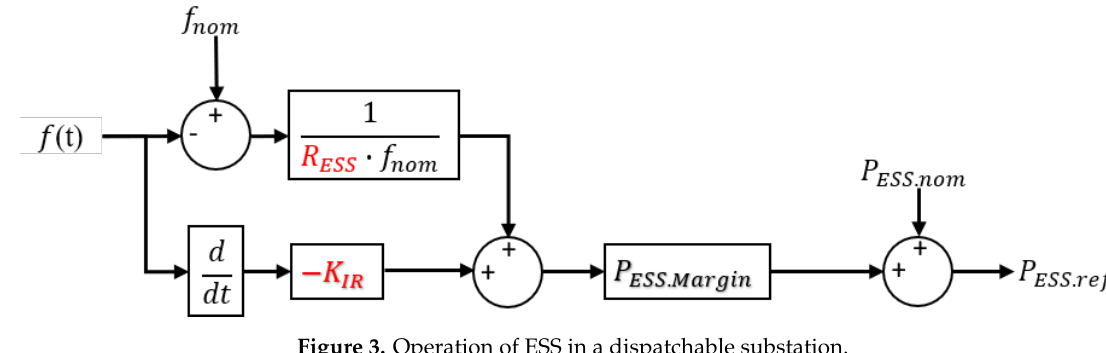
Figure 3. Operation of ESS in a dispatchable